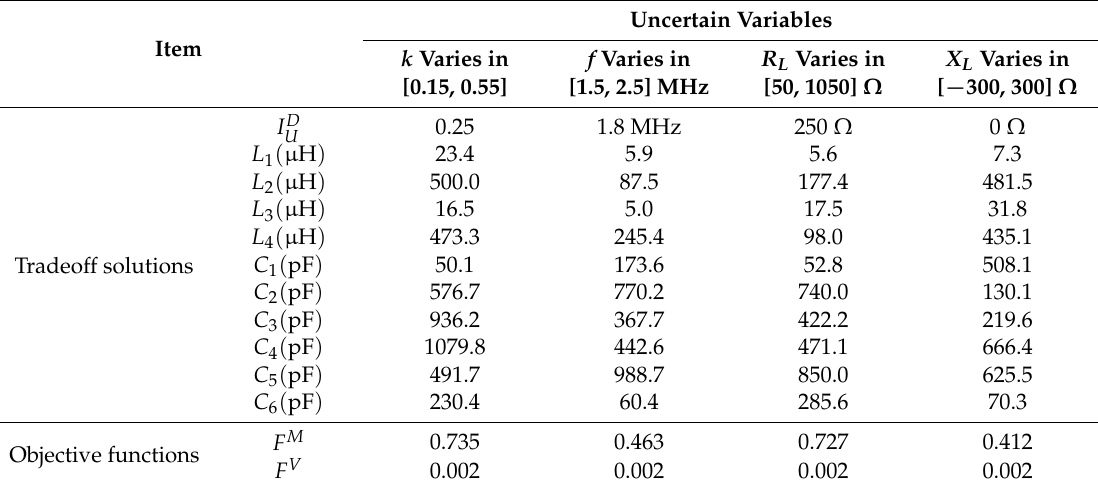
Table 5. The tradeoff solutions for the modified WPT system.